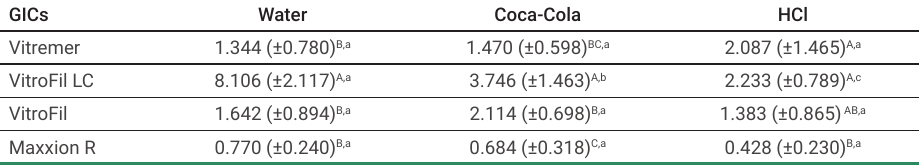
Table 3. Mean (SD) values of repair strength (MPa) of glass ionomer cements (GIC) after challenges. GICs Water Coca-Cola HCl Vitremer 1.344 (±0.780) B,a 1.470 (±0.598) BC,a 2.087 (±1.465) A,a VitroFil LC 8.106 (±2.117) A,a 3.746 (±1.463) A,b 2.233 (±0.789) A,c VitroFil 1.642 (±0.894) B,a 2.114 (±0.698) B,a 1.383 (±0.865) AB,a Maxxion R 0.770 (±0.240) B,a 0.684 (±0.318) C,a 0.428 (±0.230) B,a